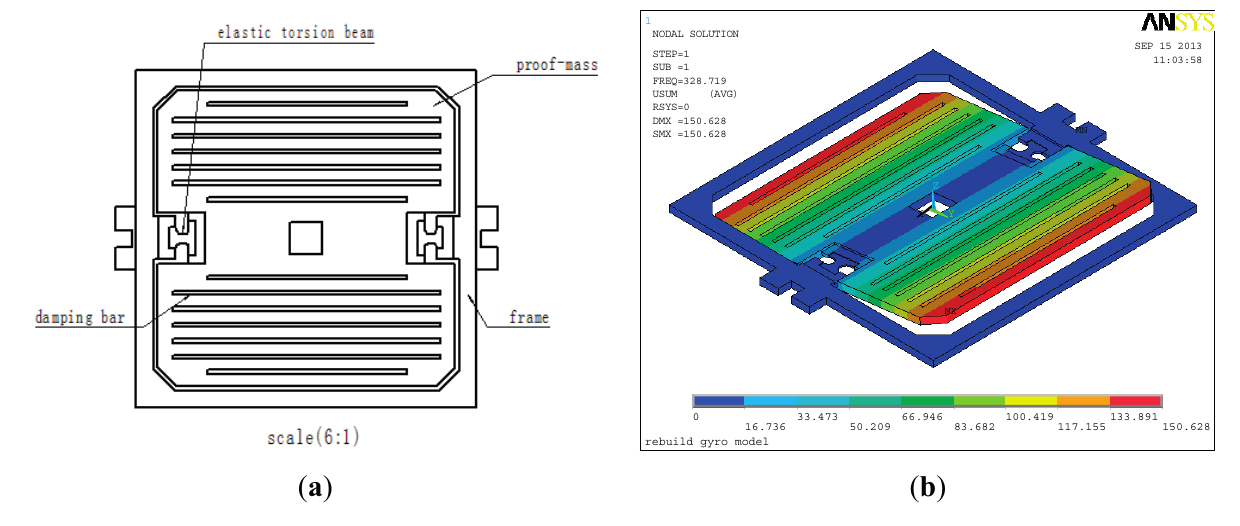
Figure 1. ( a ) The structural diagram; ( b ) the vibrating